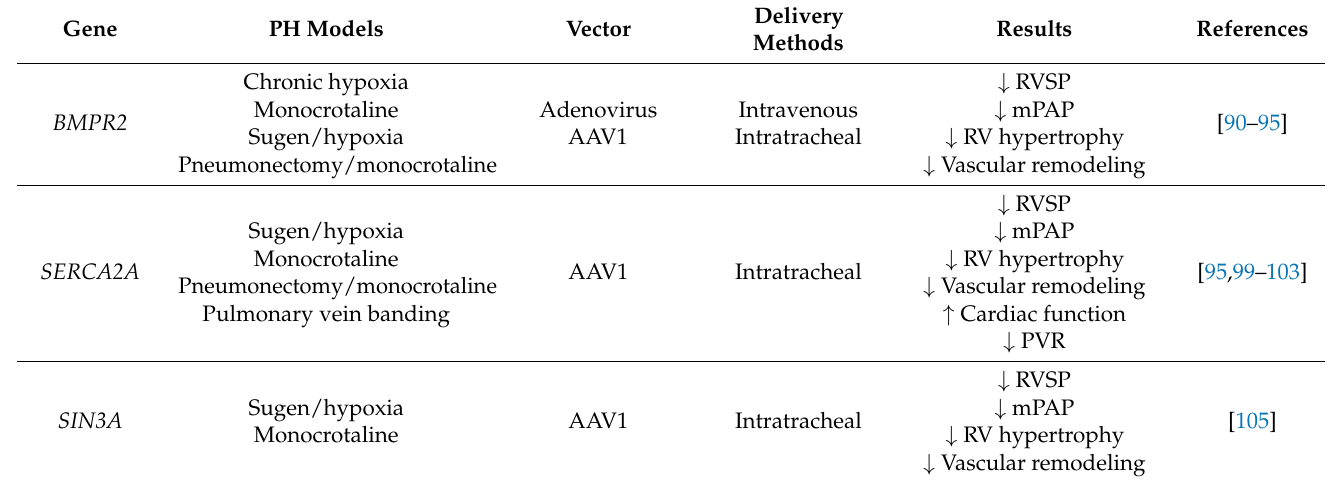
Table 1. Gene therapy in pulmonary hypertension. Table 1 displays the main therapeutic genes used for treating pulmonary hypertension (PH) in preclinical studies. Here, we show the PH models, type of vector, delivery methods, and reported